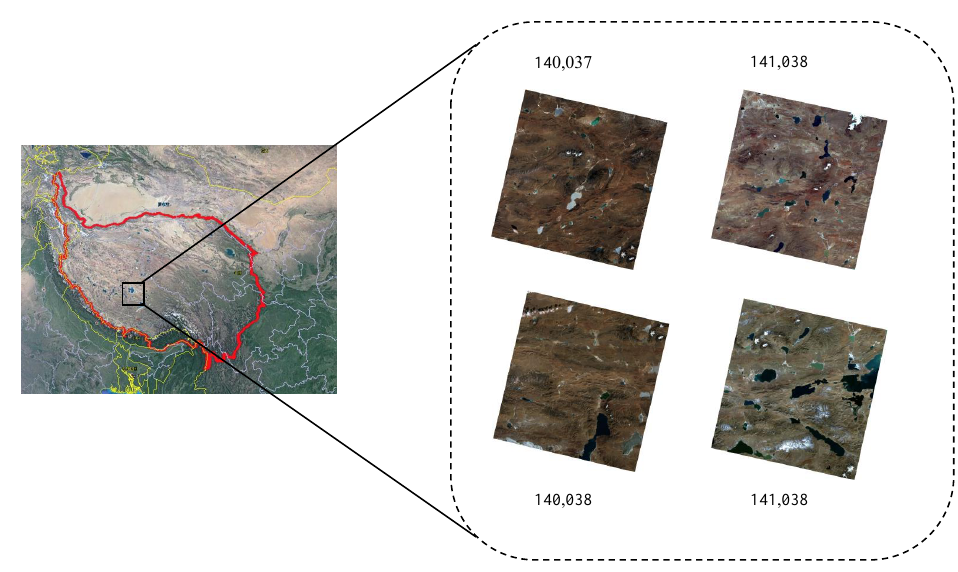
Figure 6. The location of images in the Landsat-8 dataset.